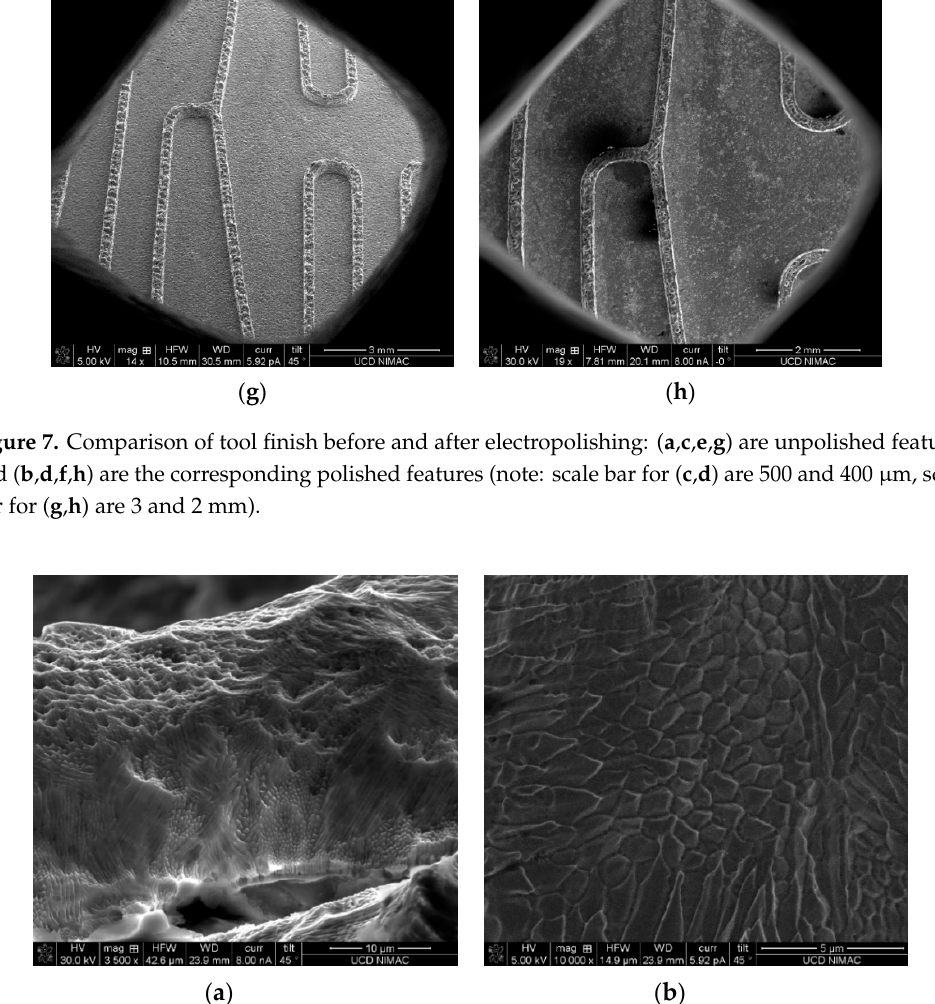
Figure 8. Surface nanostructure on electropolished micro patterns: ( a ) overview of laser melting track after polishing and ( b ) detailed surface submicron features.